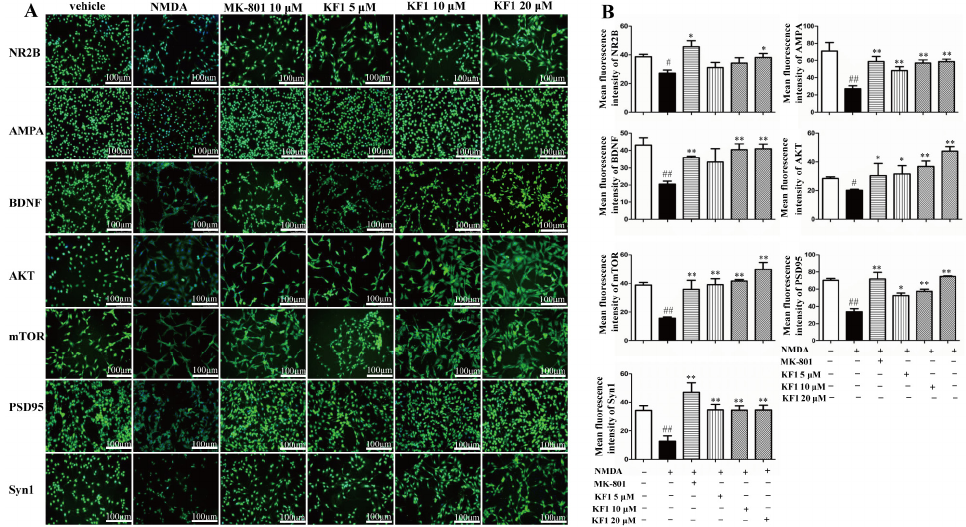
Figure 3. The immunofluorescence of NR2B, AMPA, BDNF, AKT, mTOR, PSD95, and Syn1 in PC12 cells. ( A ) Fluorescence images. ( B ) The mean fluorescence intensity of NR2B, ## p < 0.01 versus vehicle group, ** p < 0.01 versus NMDA group; AMPA, ## p < 0.01 versus vehicle group, * p < 0.01 versus NMDA group; BDNF, ## p < 0.01 versus vehicle group, * p < 0.01 versus NMDA group; AKT, # p < 0.01 versus vehicle group, * p < 0.05, ** p < 0.01 versus NMDA group; mTOR, ## p < 0.01 versus vehicle group, ** p < 0.01 versus NMDA group; PSD95, ## p < 0.01 versus vehicle group, * p < 0.05, ** p < 0.01 versus NMDA group; and Syn1 ## p < 0.01 versus vehicle group, ** p < 0.01 versus NMDA group;. Green fluorescence represents fluorescent staining, and blue fluorescence represents DAPI-stained nuclei. Bars: 100 µ m, the data represent mean ± SEM ( n =